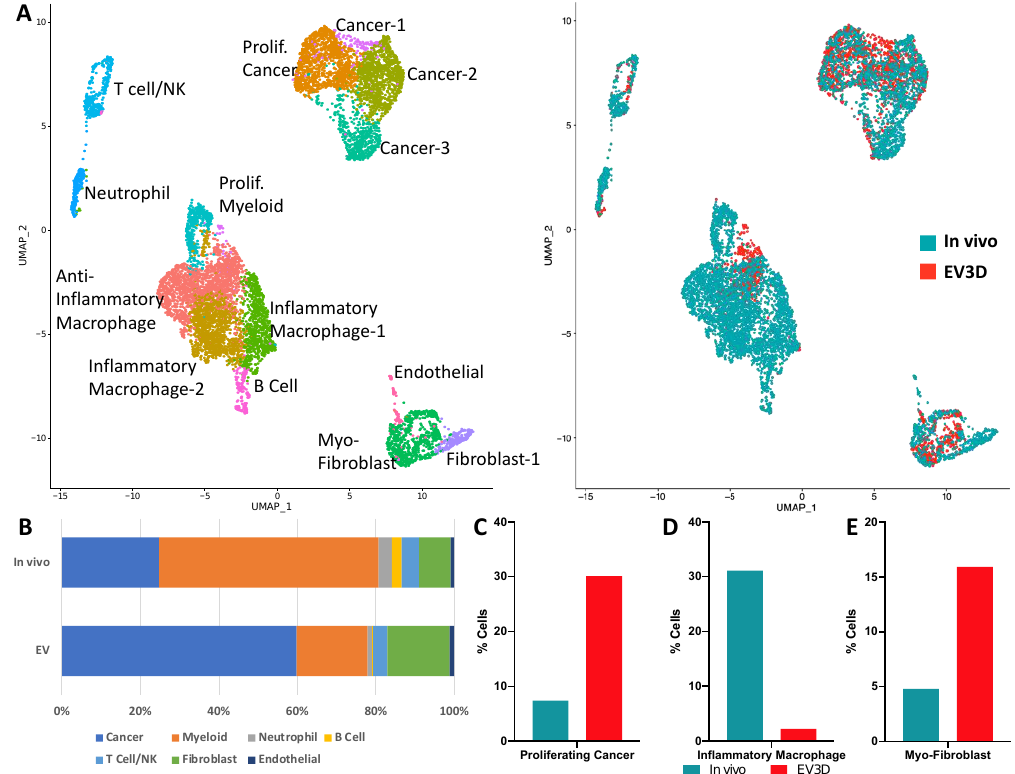
Figure 8. Single-cell RNA-seq analysis of 4T1 tumor and tumoroid cultures. ( A ) Merged uniform manifold approximation and projection (UMAP) of identified cells from a syngeneic tumor (in vivo) and 5-day ex vivo tumoroid (EV3D) cultures. ( B ) Cell type abundance from original tumor and tumoroids. ( C ) Abundance of proliferating cancer cells (Epcam + /Mki67 + ) in tumor/tumoroid. ( D ) Abundance of inflammatory macrophages (Ptprc + /CD14 + /Il1b + ) in tumor/tumoroid. ( E ) Abundance of myofibroblast (Thy1 + /Dcn + /Acta2) in tumor/tumoroid. The 4T1 syngeneic tumors had high immune (Ptprc/CD45 + ) infiltration, with a high abundance of myeloid-derived neutrophils (3.4%) and monocytes/macrophages (55.9%) (Figure 8A). During ex